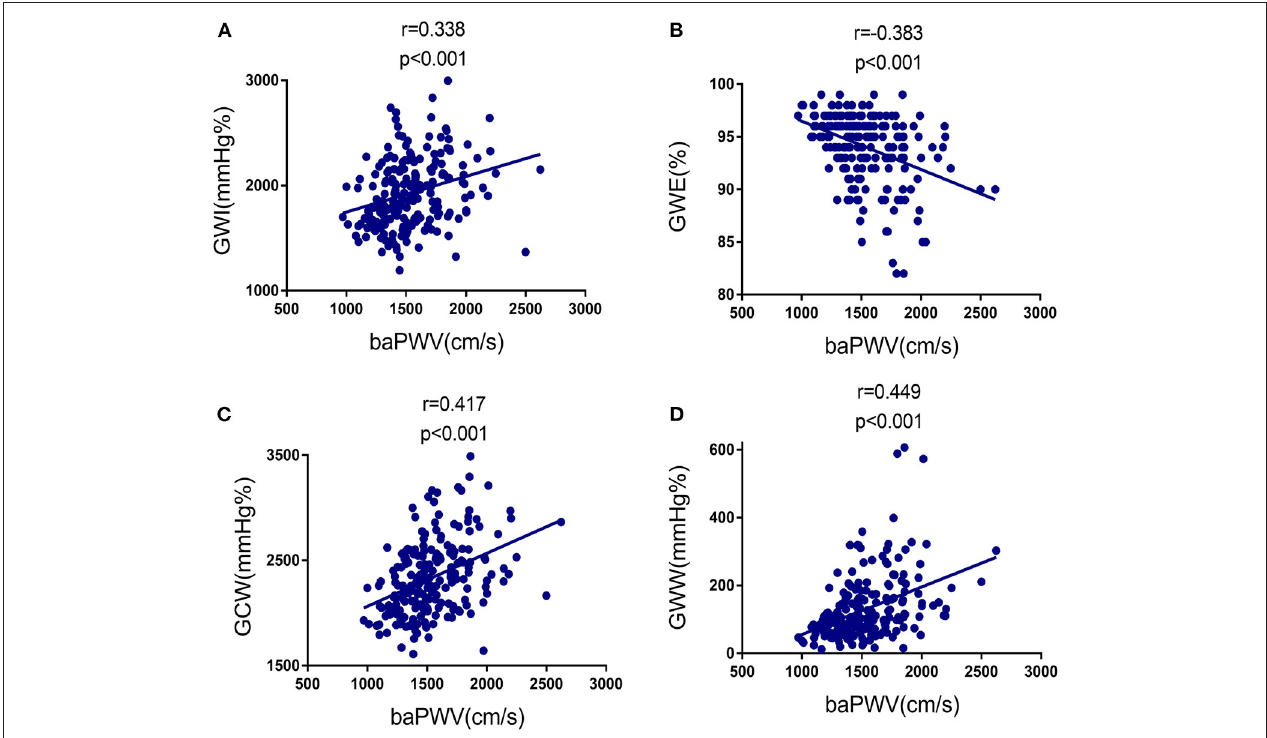
FIGURE 2 | Correlation between baPWV and the four components of MW in the study population. (A) Relationship of baPWV to GWI. (B) Relationship of baPWV to GWE. (C) Relationship of baPWV to GCW. baPWV, brachial-ankle pulse wave velocity; GCW, global constructed work; GWE, global work efficiency; GWI, global work index; GWW, global wasted work; MW, myocardial work. TABLE 3 | Association of baPWV with global work index, global work efficiency, global constructed work and global wasted work. Univariable analysis Multivariable